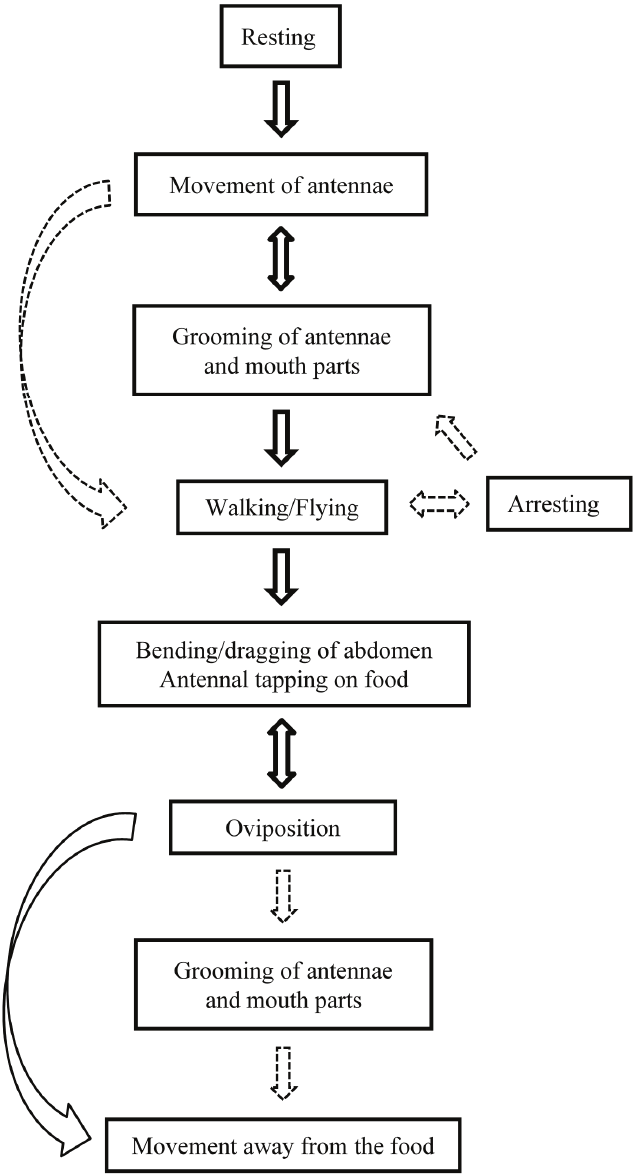
Figure 1. A representative diagram of sequential pre- and post-oviposition behaviors displayed by gravid female Plodia interpunctella . Solid arrows indicate frequently observed behaviors, whereas dashed arrows indicate occasional behaviors. Bidirectional arrows indicate behaviors that occur alternatingly with another behavior.